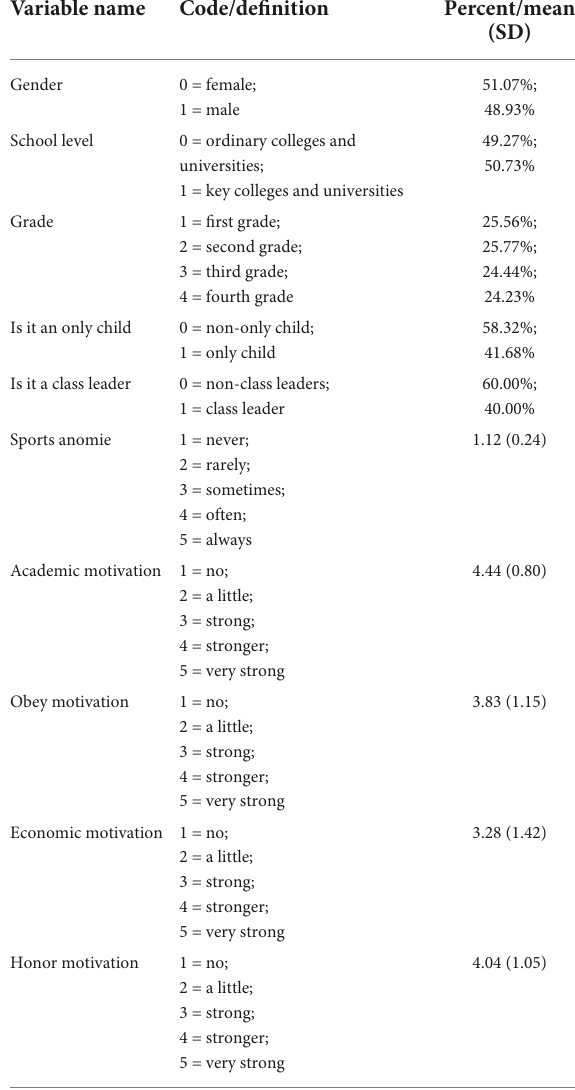
TABLE 1 Descriptive statistics of sample characteristics ( n =